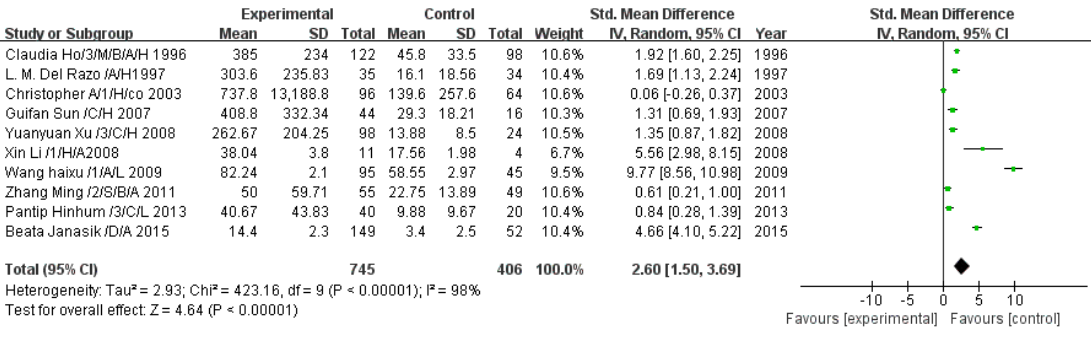
Figure 5. Effect of arsenic exposure on dimethyl arsenic (DMA) concentration in urine. Std., standardized; SD, standard deviation; IV, independent variable; CI, confidence interval.